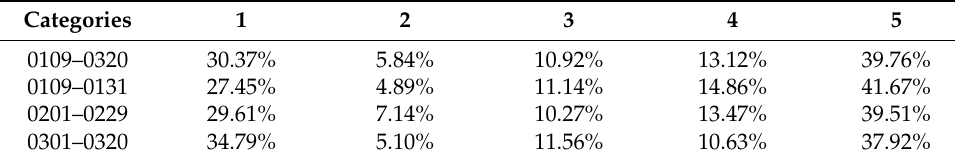
Table 5. The distribution of atmospheric stability at site